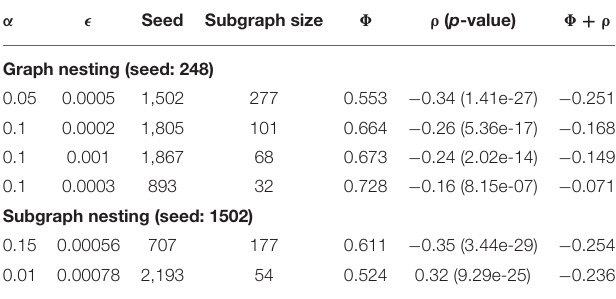
TABLE 4 | Results of graph and subgraph